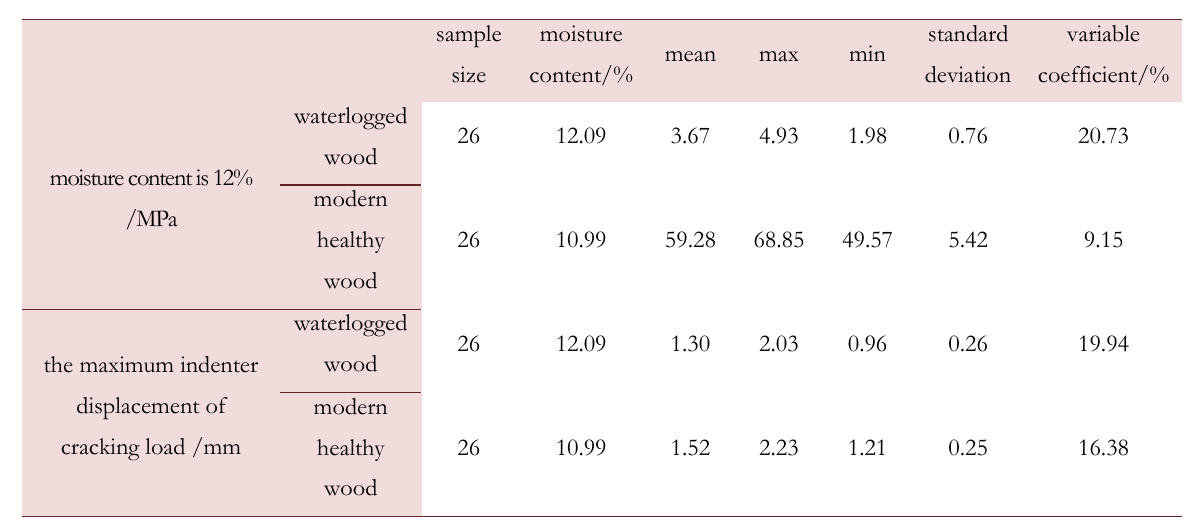
Table 3: compression strength parallel to grain of Pinus yunnanensis ancient wood and healthy wood.